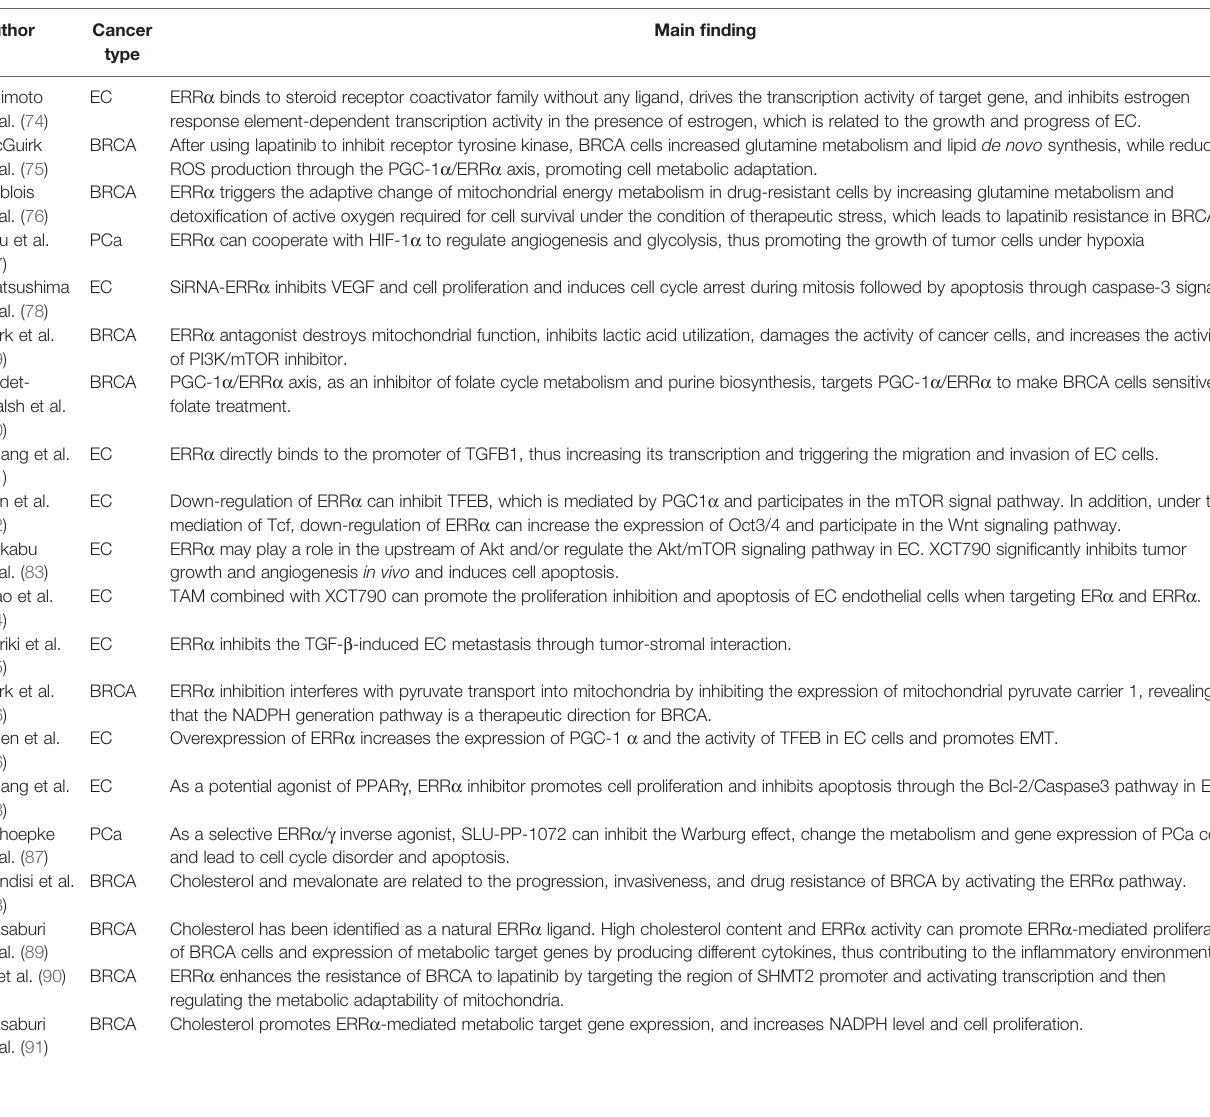
TABLE 2 | Studies on ERR a regulation of glucose and lipid metabolism and promotion of hromone-related tumor